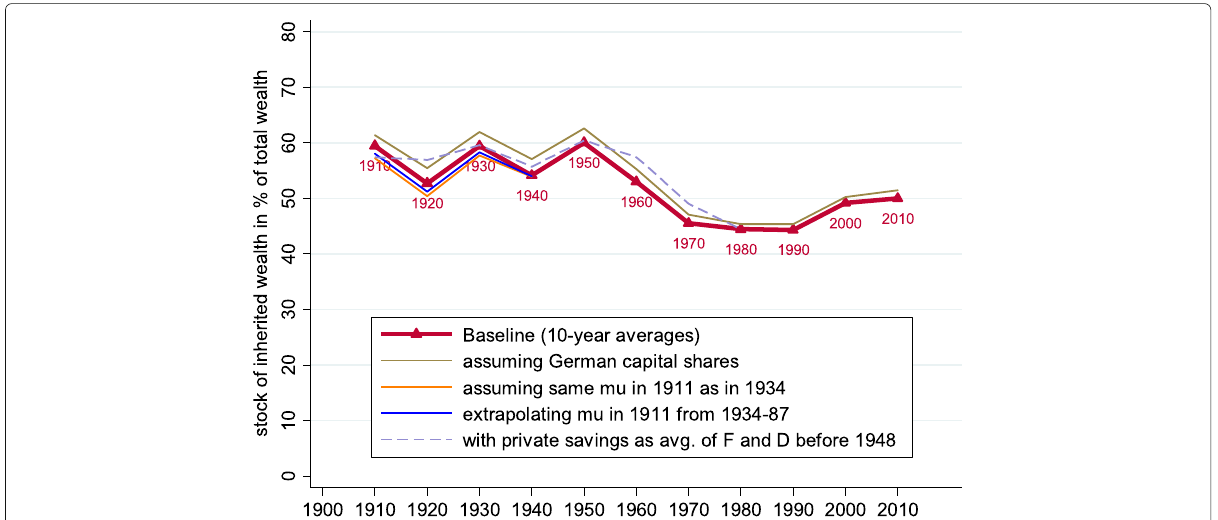
Fig. 8 Cumulative stock of inheritances as a fraction of private wealth: robustness to alternative assumptions. Notes: data points are 30-year moving averages, reported every 10 years. See text for data